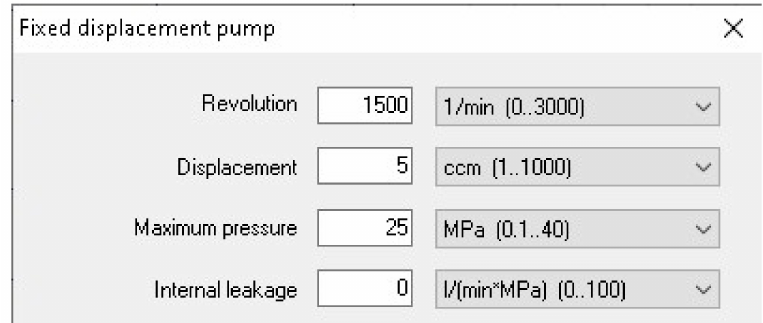
Figure 18. Pump unit parameters setup.